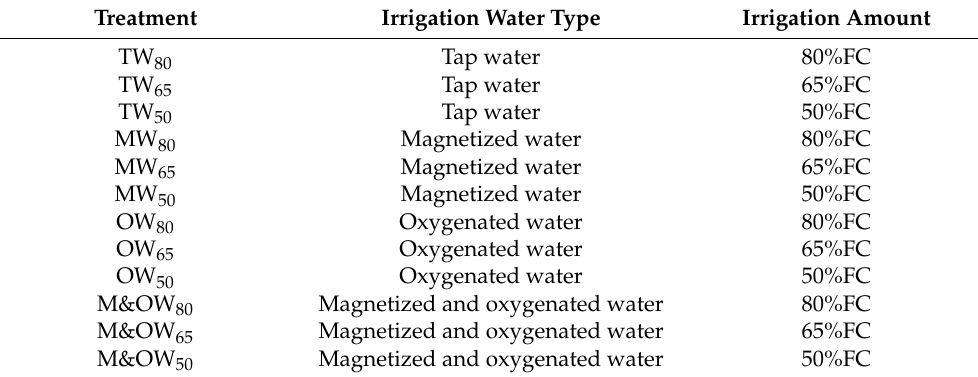
Table 1. Design of the activated water irrigation